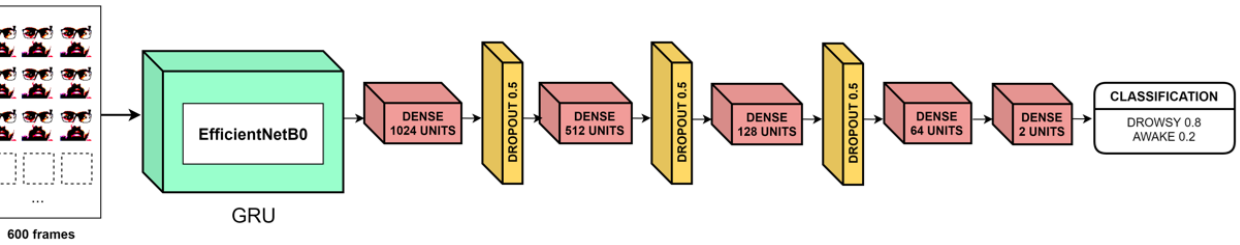
Figure 5. Architecture of the model used for drowsiness